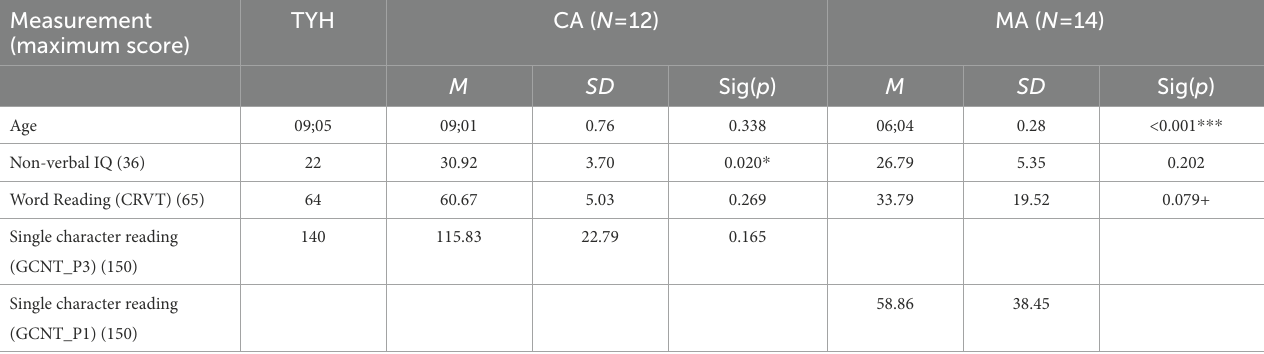
TABLE 3 Age, non-verbal IQ, and reading ability measures of control participants with comparison to TYH. Measurement (maximum score)